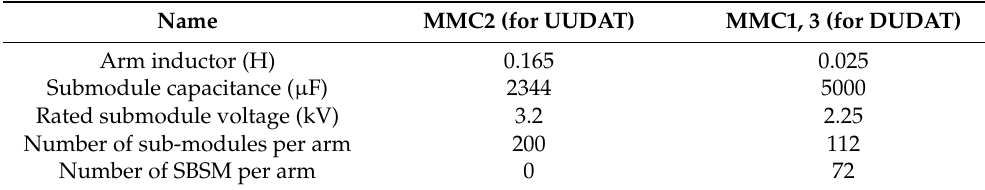
Table 4. Parameters of the MMC1, 3 in the simulated DUDAT and MMC2 in the simulated UUDAT.